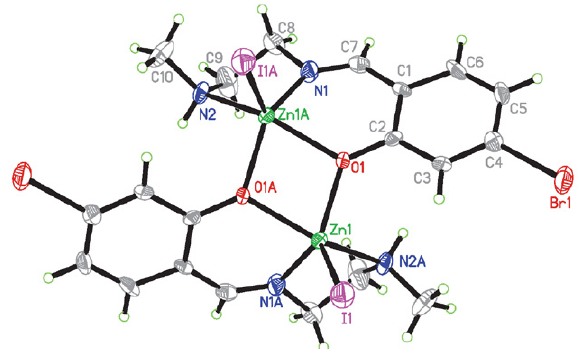
Fig. 2. Molecular structure of complex 2 . Atoms labeled with the suffix A are related to the symmetry operation 1 – x , 1 – y , z .